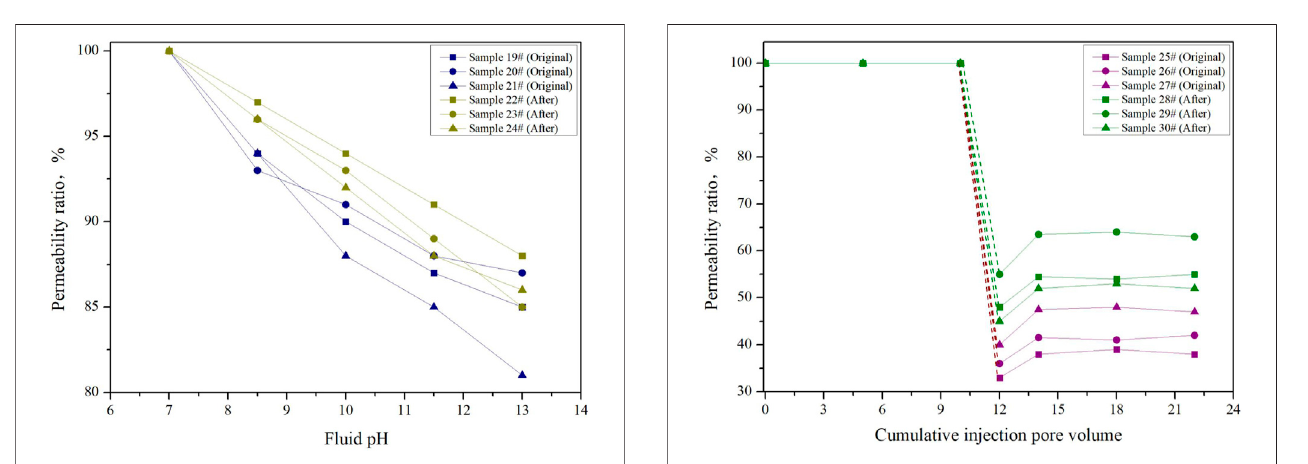
FIGURE 11 | Effect of supercritical CO 2 on alkali sensitivity. FIGURE 12 | Effect of supercritical CO 2 on acid